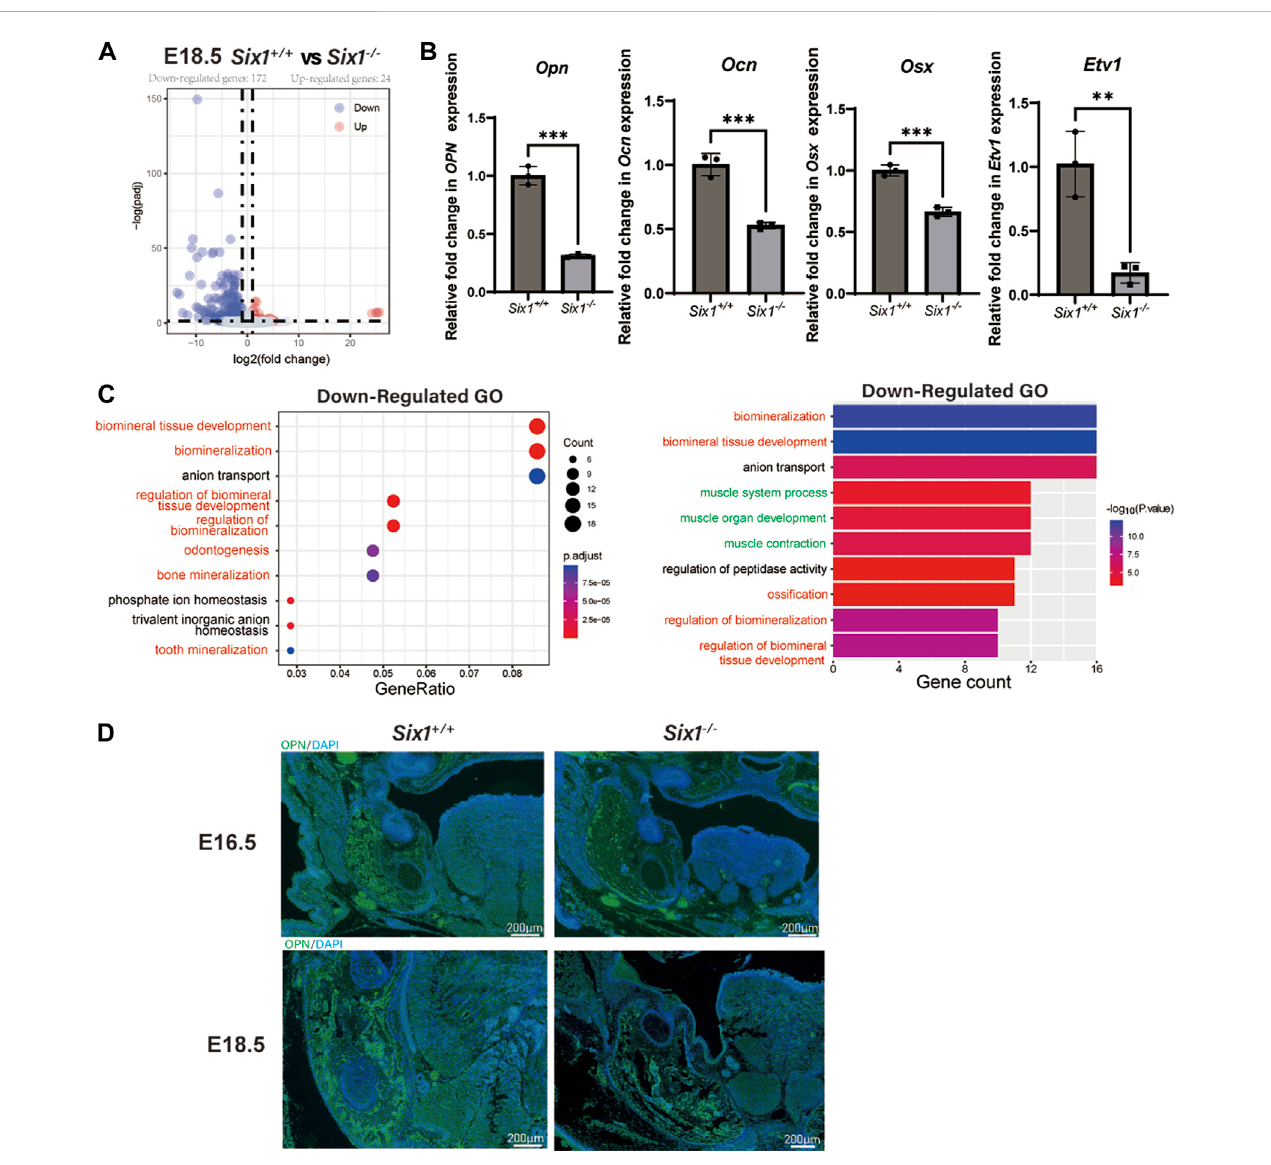
Six1 +/+ mandibular samples. (B) RT-qPCR analysis of Opn , Ocn, Osx and Etv1 in Six1 − / − and Six1 +/+ mandibular tissues at E18.5. (C) GO enrichment analysis of genessigni fi cantly downregulated in Six1 − / − mandible. (D) Immuno fl uorescence stainingof OPN inmandible of Six1 − / − and Six1 +/+ embryos atE16.5and